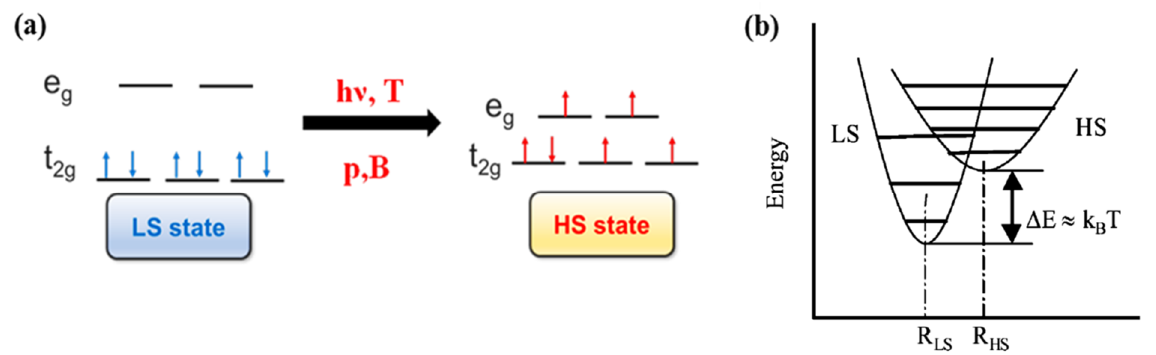
Figure 1. ( a ) The electronic configuration of low spin (LS) and high spin (HS). ( b ) The relative potential energy diagram of low spin (LS) and high spin (HS) states. Reprinted with permission from Ref. [40]. Copyright 2004 Springer.